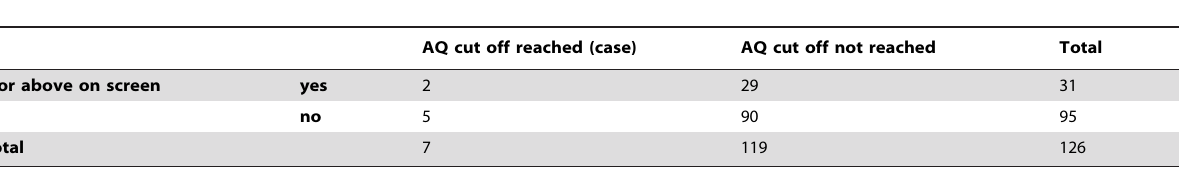
AQ cut off reached